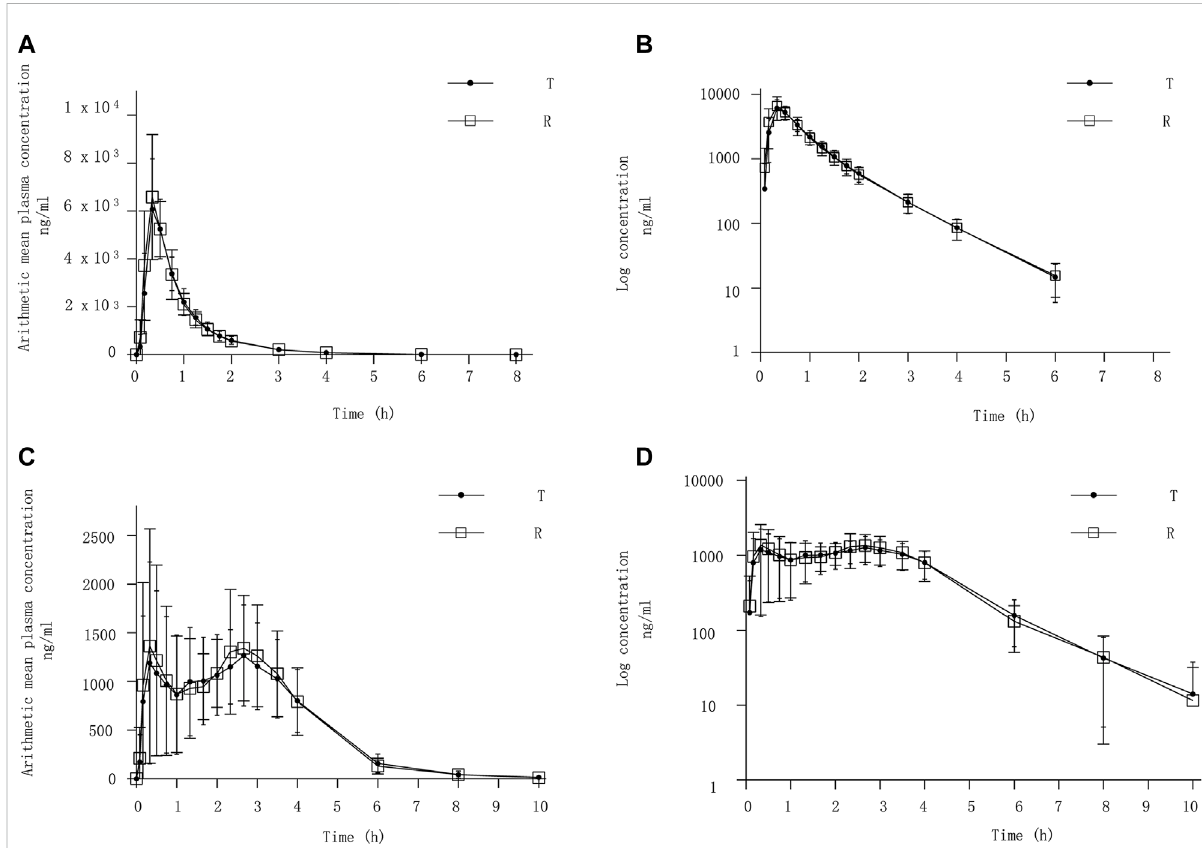
FIGURE 2 PK analysis of Cefaclor granule and Cefaclor suspension. T, test drug was Cefaclor granule; R, reference drug was Cefaclor suspension; Mean blood concentration (±SD) time curve after oral administrated Cefaclor granule and Cefaclor suspension during fasting: arithmeticmean (A) and log transformation (B) . Mean blood concentration (±SD) time curveafter oral Cefaclor granuleand Cefaclorsuspension in postprandialstate: arithmetic mean (C) and log transformation (D)